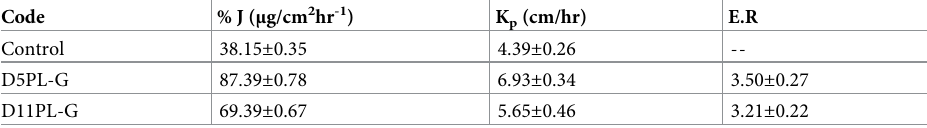
Table 4. Permeation analysis of Liposomal gel.